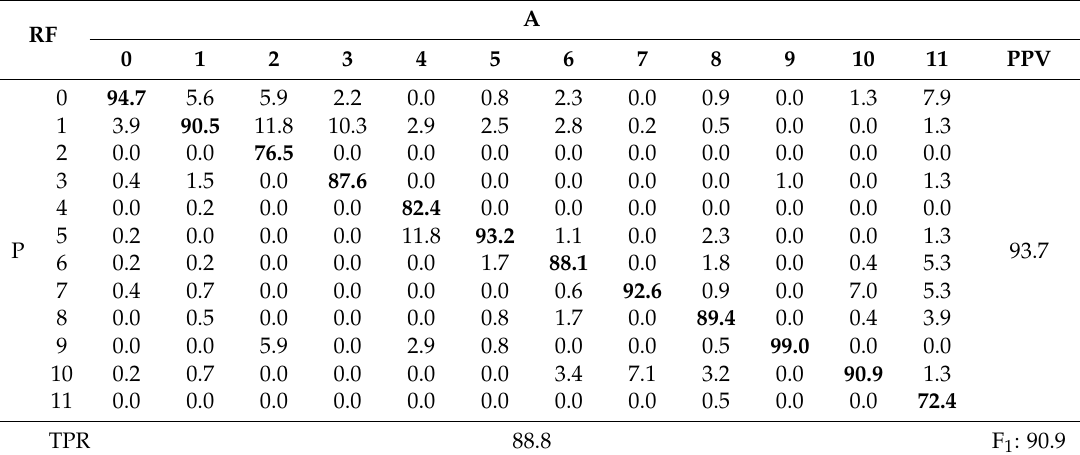
Table 12. The Confusion Matrix of the Random Forest